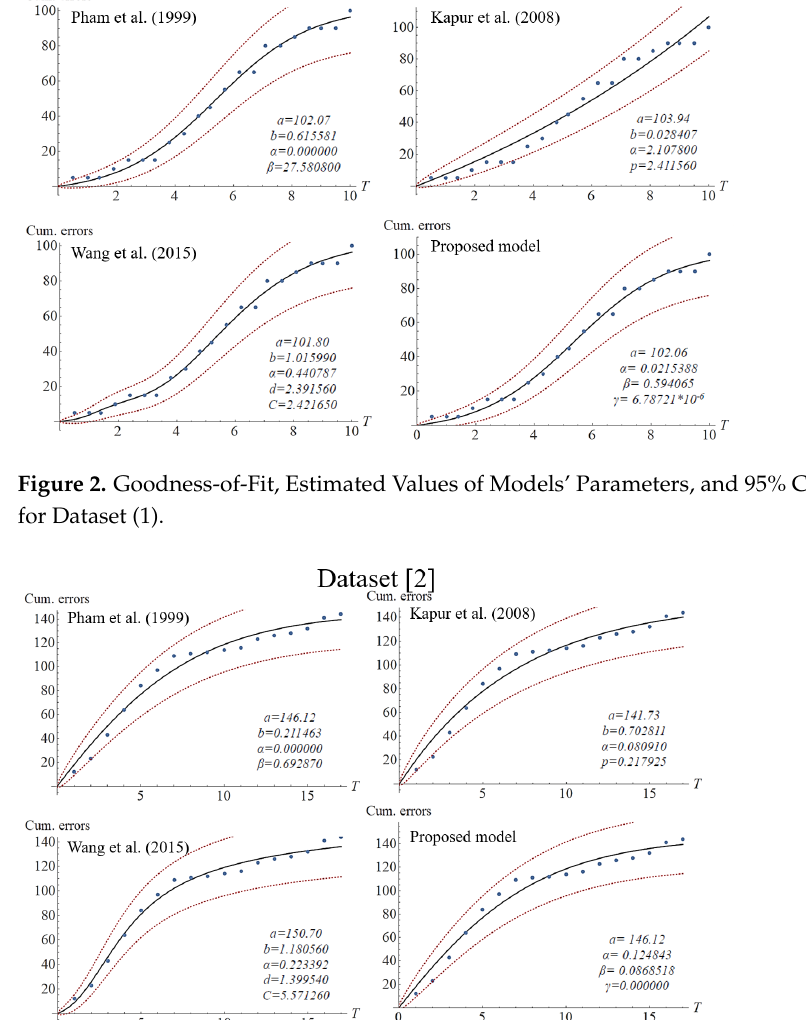
Figure 4. Goodness-of-Fit and Estimated Values of Models’ Parameters, and 95% Confidence Inter- vals for Dataset (3). After the analysis of Goodness-of-Fit, it can be seen that the proposed model mostly outperforms the others in the criteria of MSE, R-squared, and AIC under datasets 3 and 4. Moreover, referring to the details in Table 5 and Figures 2 and 3, we can see that Wang’s model presents an extremely fitting ability for datasets 1 and 2, with R-squared values of 99.43% and 98.81%, respectively. In general, such indicators can measure a model’s per- formance in adapting to different data patterns, and decision-makers can utilize the ap- plicability of different scenarios to accurately predict the future. However, the situation of overfitting should also be avoided. Examining the bottom-left corners of Figures 2 and 4 for Wang’s model, we can observe the fluctuating curves to fit datasets 1 and 3, which might be due to the phenomenon of overfitting. Overfitting is as an error that occurs in data modeling, in which a particular function may align too closely to a specific dataset but not to other datasets. In other words, a model may overly learn the detail and noise in a specific training dataset. Obviously, the phenomenon of overfitting may negatively im- pact the performance of a model for new and future datasets. Although the performance of our model may not be superior to that of Wang’s, such overfitting did not show in our model because the proposed model did not show fluctuating curves to fit datasets. It is worth noting that the number of model parameters can influence the fitting ability. In practice, increasing the number of model parameters can effectively improve a model’s